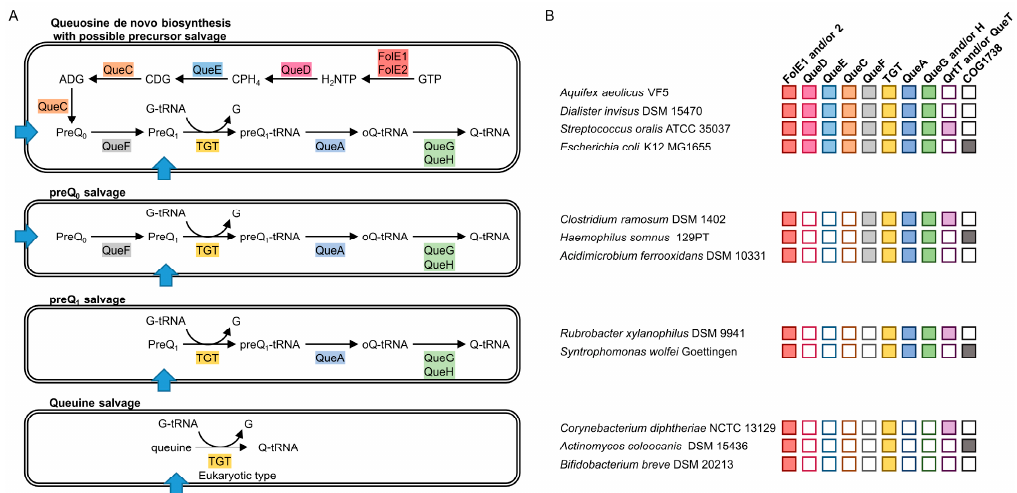
Figure 1. Prediction of Queuosine biosynthesis and salvage pathways. ( A ) Variation among the biosynthesis and salvage capabilities, with predicted transporters represented by blue arrows; ( B ) illustration of the presence of the corresponding genes in representative bacteria. Boxes are colored when the gene is present and empty boxes are for when the gene is absent. Abbreviations: FolE1 and FolE2: GTP cyclohydrolase I (EC 3.5.4.16); QueD : 6-carboxytetrahydropterin synthase (EC 4.1.2.50);